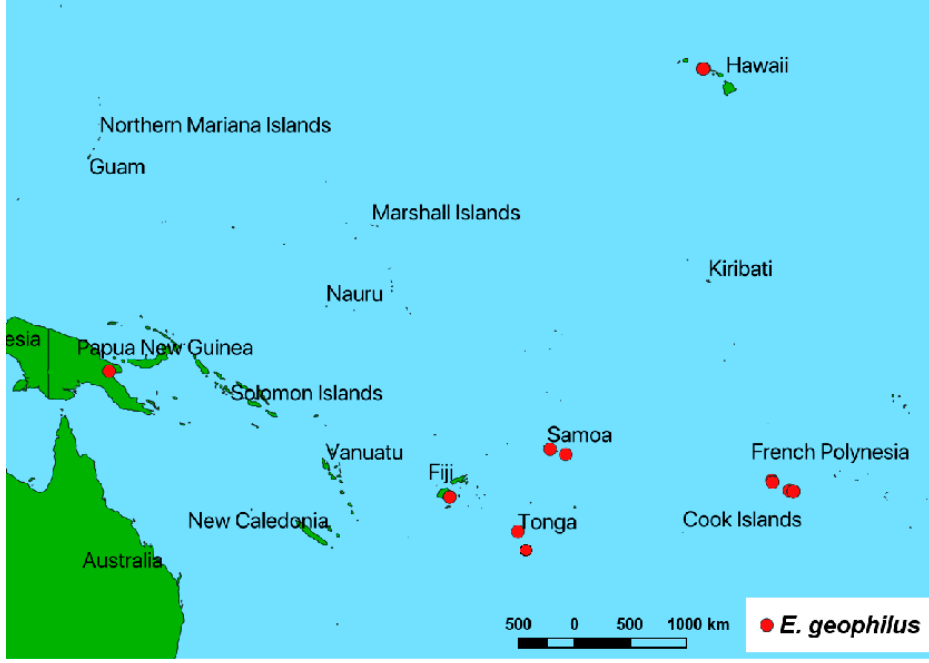
Figure 1. Known distribution of E. geophilus .